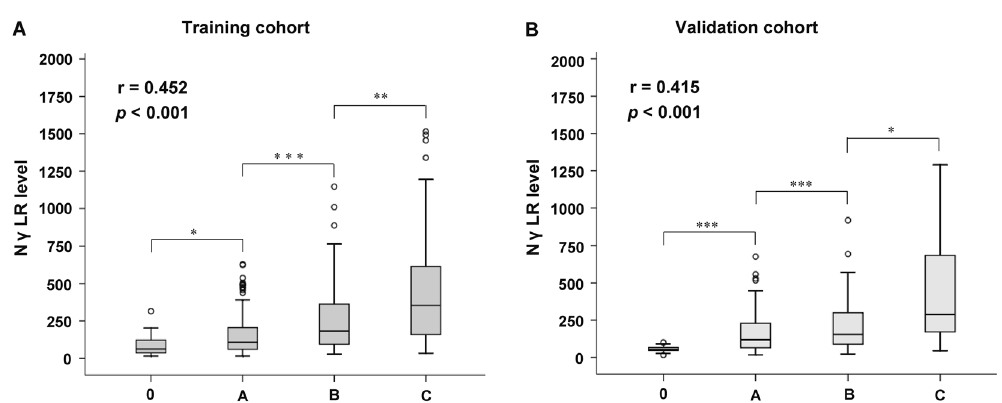
Figure 5. Box plots of N γ LR values according to the BCLC stage in the training (A) and validation (B) cohorts. ( * P < 0.05; ** P < 0.01; *** P <